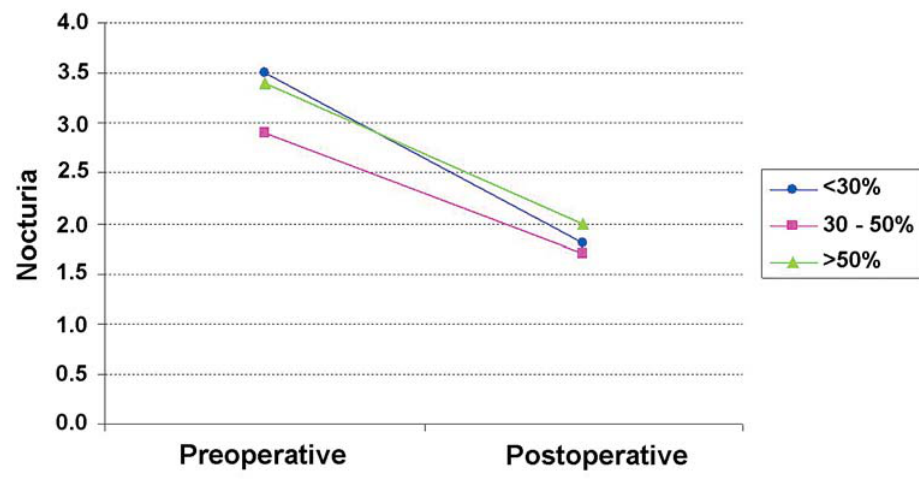
Figure 3 – Variation of nocturia according to percentage of resected tissue.